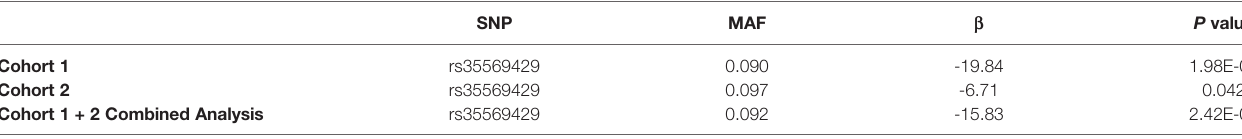
TABLE 1 | Cohort 1, 2 and combined association analysis